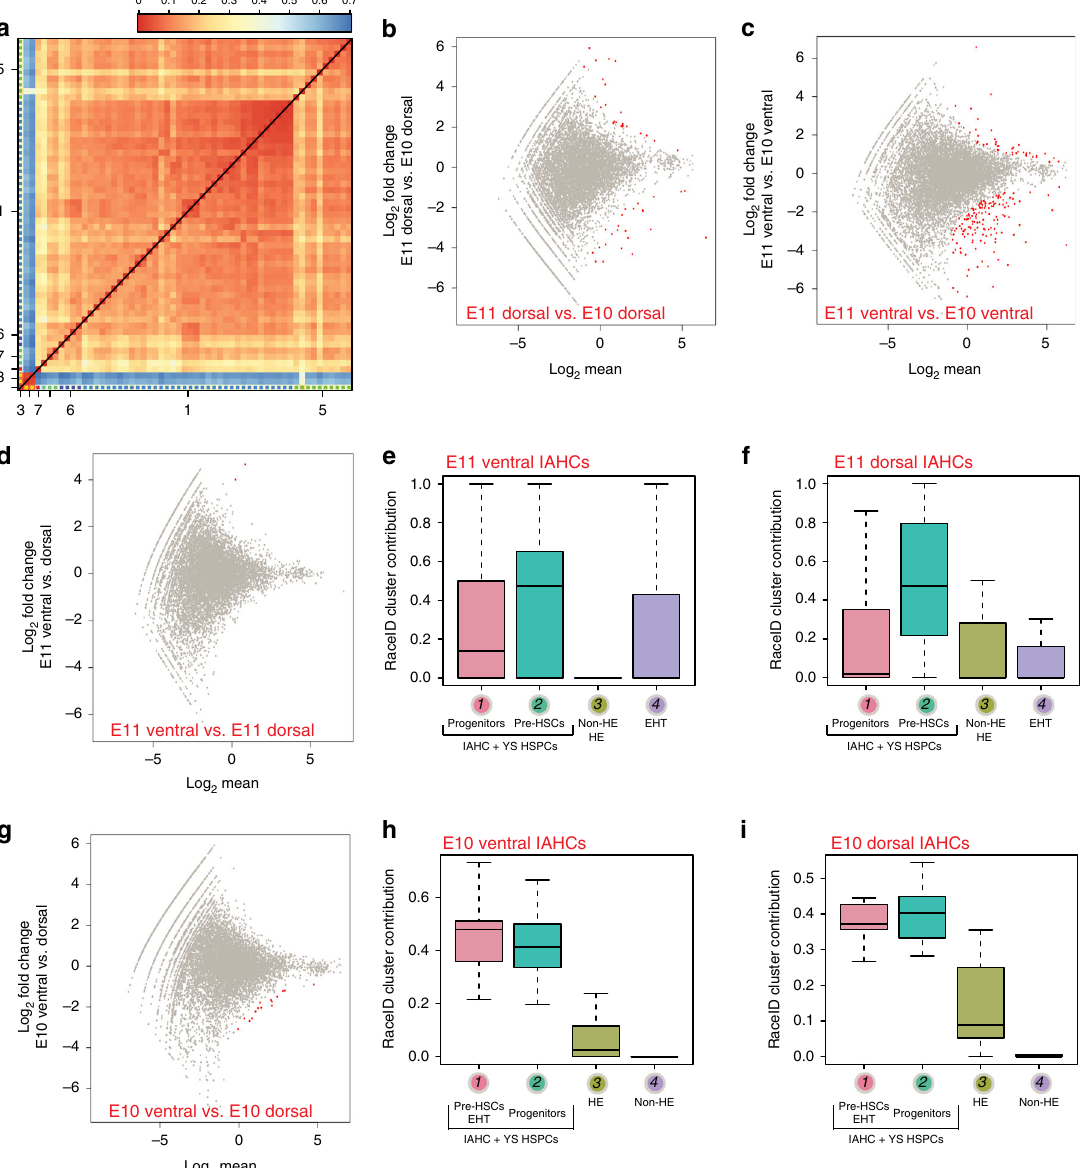
Fig. 6 Ventral and dorsal wIAHCs have a similar transcriptome at E10 and E11. a Heatmap representing the transcriptome similarities measured by the Euclidean distance of the transcriptome correlation matrix for single E10 and E11 wIAHCs. Cluster numbers are shown along the axis for the major clusters. b – d , g DE-Seq analysis showing the differential gene expression between E11 and E10 dorsal wIAHCs (51 genes signi fi cantly differentially expressed as shown by red dots) ( b ), between E11 and E10 ventral wIAHCs (199 genes) ( c ), between E11 ventral and dorsal wIAHCs (2 genes) ( d ), and between E10 ventral and dorsal wIAHCs (16 genes) ( g ). e , f Box plots of the RaceID cluster contribution to E11 ventral ( e ) and dorsal ( f ) wIAHCs. Color-coded boxes are related to RaceID analysis shown in Fig. 2d. h , i Box plots of the RaceID cluster contribution to E10 ventral ( h ) and dorsal ( i ) wIAHCs. Color-coded boxes are related to RaceID analysis shown in Fig.